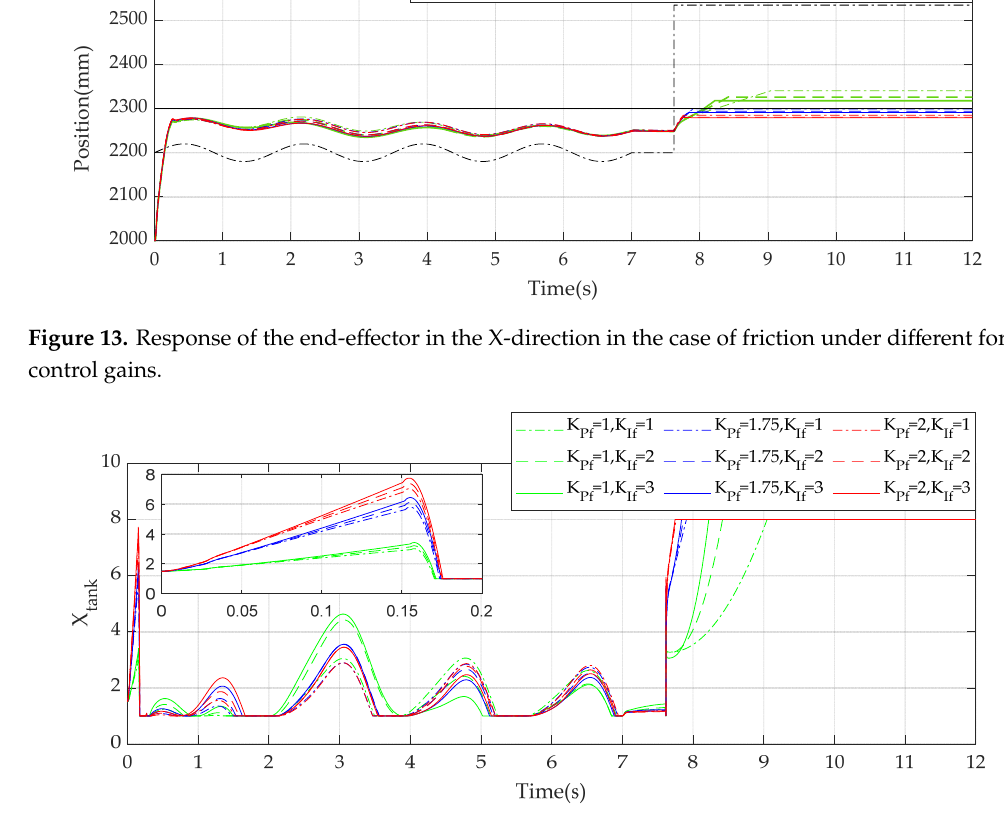
Figure 14. Response of the energy variable in the case of friction under different force control gains.